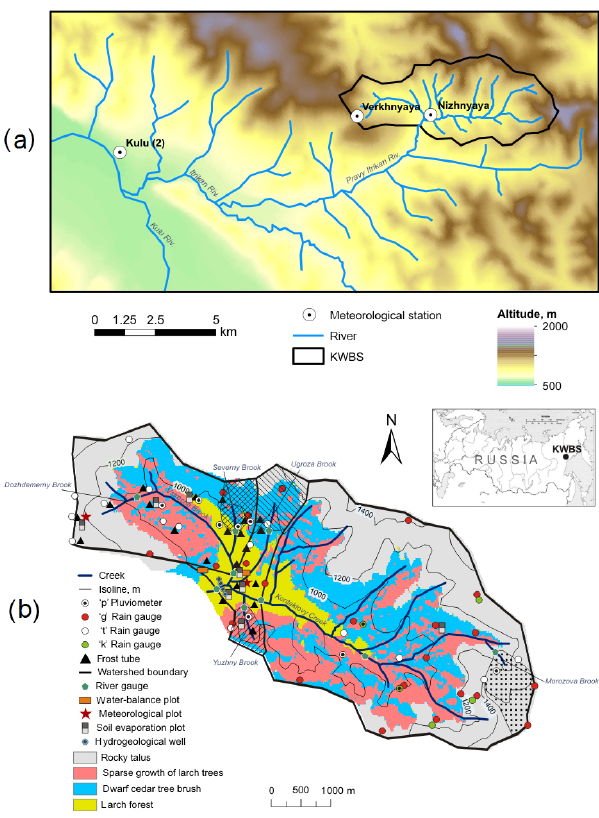
Figure 2. Scheme of the KWBS indicating the location of observa- tion